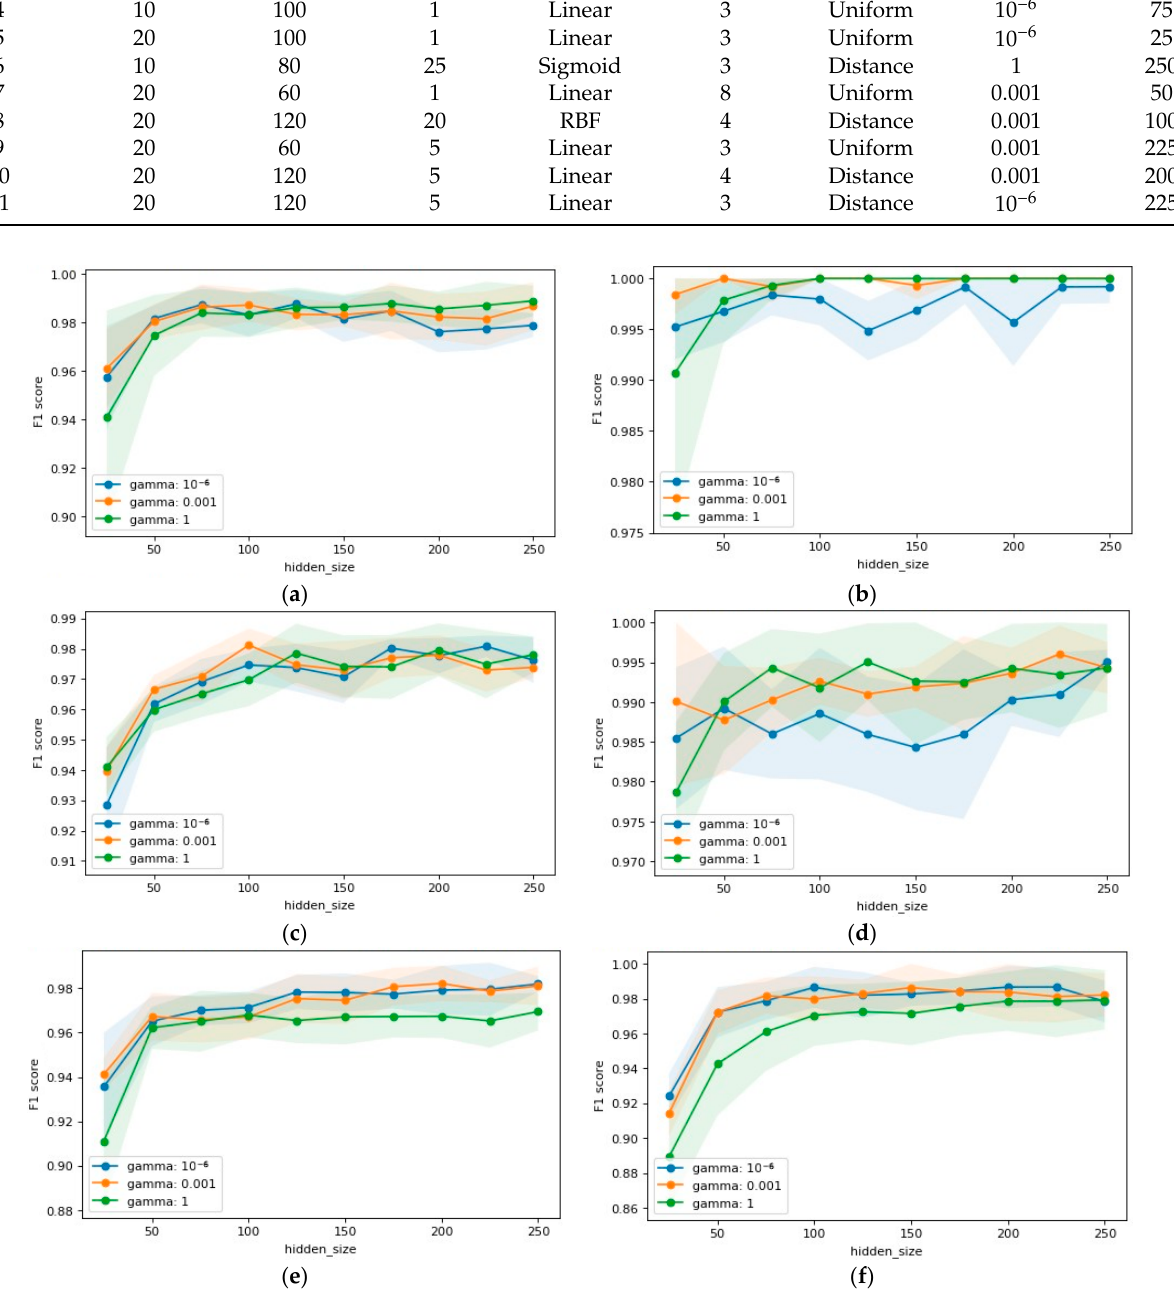
Figure 5. ELM (see Algorithms 3 and 4) hyperparameter selection for classification of program texts solving automatically generated tasks of various types (see Table 1): ( a ) task of type 6; ( b ) task of type 7; ( c ) task of type 8; ( d ) task of type 9; ( e ) task of type 10; ( f ) task of type 11. According to Figure 5, ELM performance depends on the combination of 𝛾 and 𝑑 ,